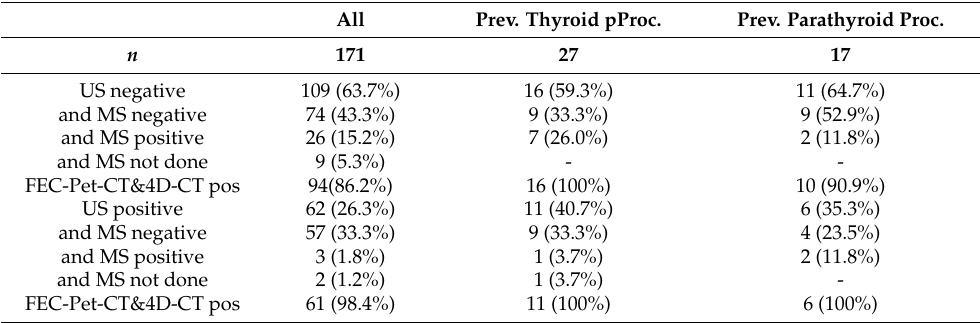
Table 2. Absolute numbers and percentage of patients with positive and negative localization of a parathyroid adenoma in the preoperative work-up for all patients and subgroups with either previous thyroid or parathyroid surgery and the respective number of positive findings in FEC-PET-